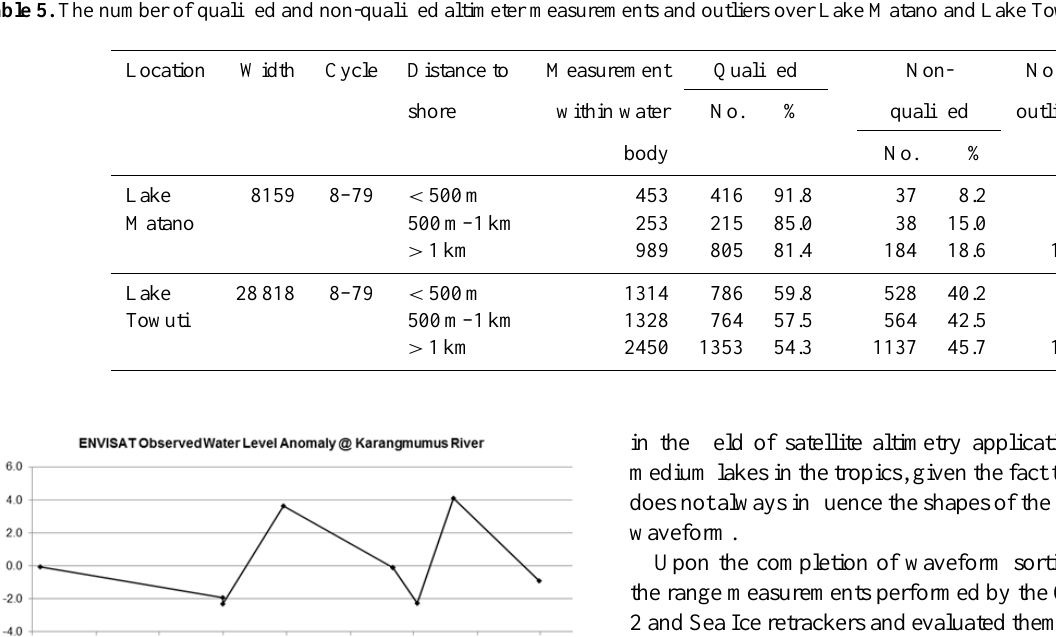
Table 5. The number of qualified and non-qualified altimeter measurements and outliers over Lake Matano and Lake Towuti.